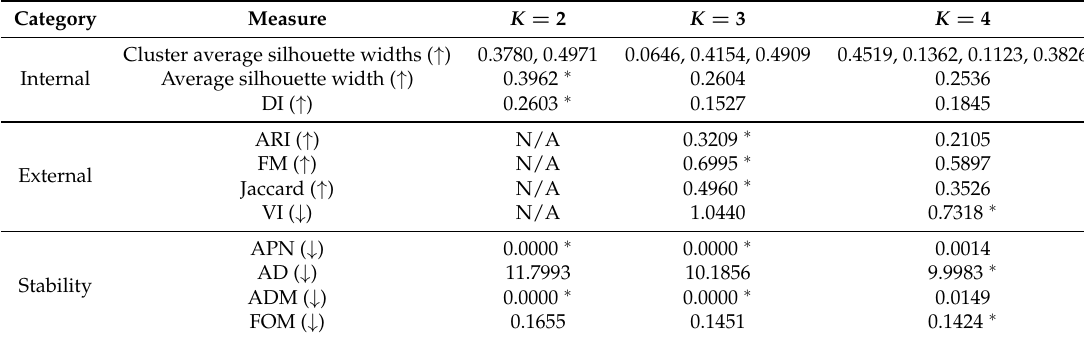
Table 3. Clustering validation of K-means with K = 2,3,4 using SFD-out